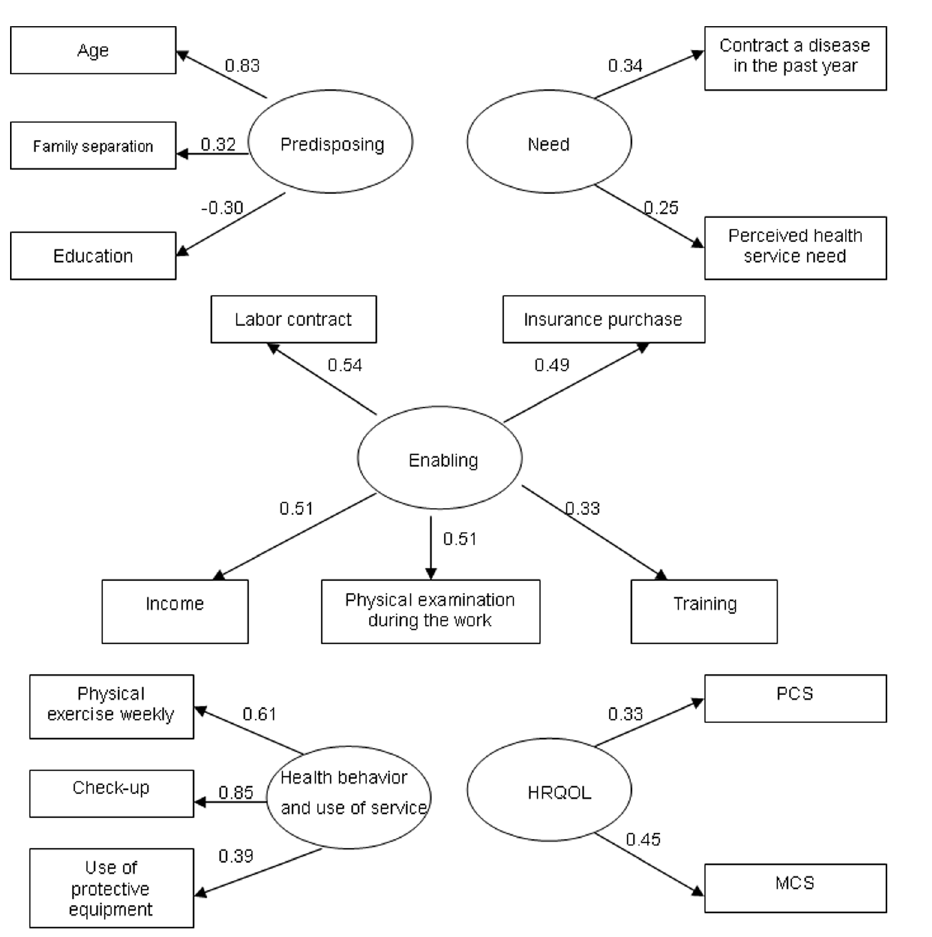
Figure 2. Measurement model of latent constructs (ellipses) and manifest indicator variables (rectangles). Values represent standardized factor loadings and all are statistically significant ( P , 0.01). GFI=0.973; CFI=0.925; TLI=0.886; RMSEA=0.045; SRMR=0.045. Chi-Square/ DF=2.736. doi:10.1371/journal.pone.0083315.g002 PLOS ONE |